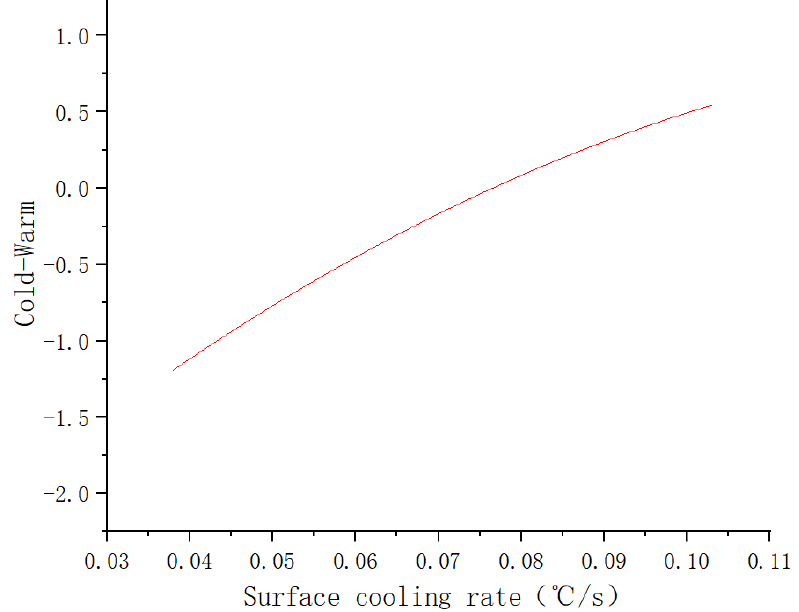
Figure 14. “Cold-Warm”-polynomial and surface cooling polynomial fitting function.